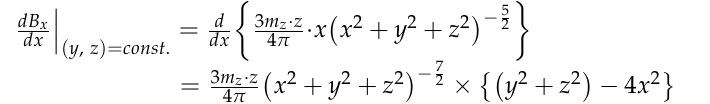
Figure 8. Variation of the extreme point when a magnetic dipole was fed on y = 50, z = 100. Based on Equation (2), the first-order differentiation of x , when the ( y , z ) was con- stant, was easily derived as follows: